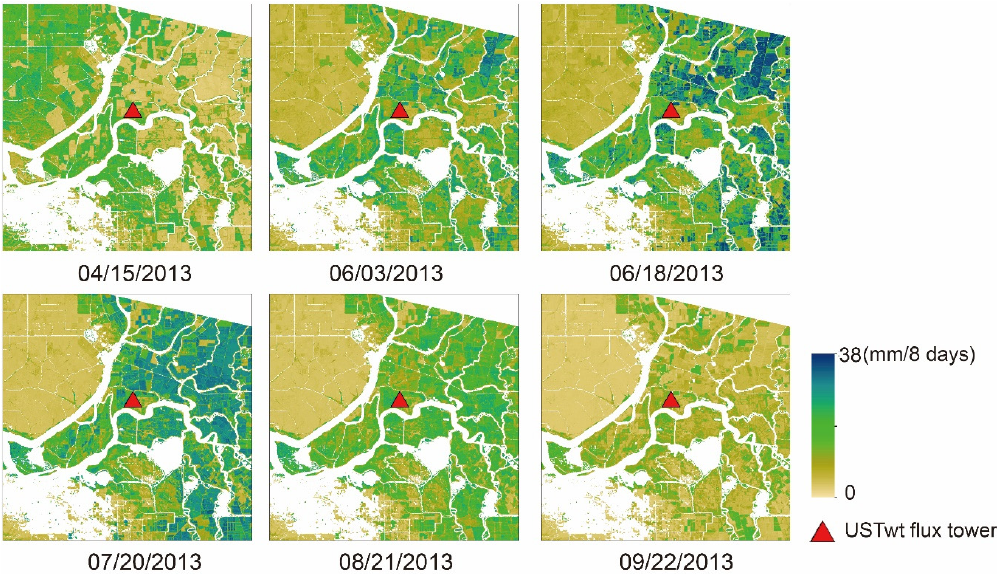
Figure 9. Zoomed view of Landsat 30 m downscaled ET (mm/8-days) in the northeast part of Site 2 during the year of 2013.